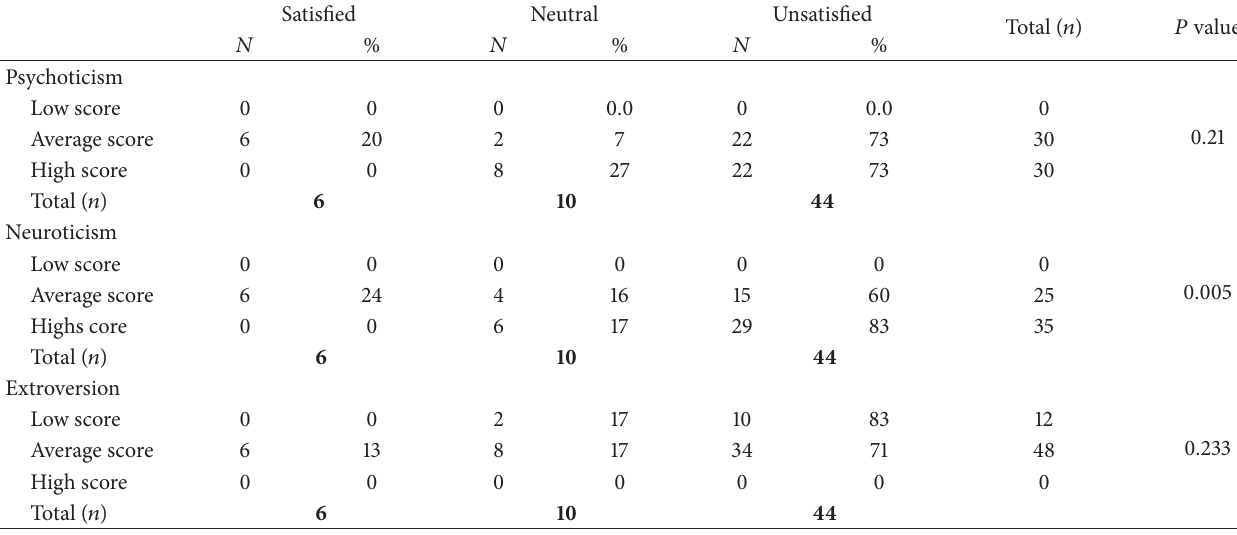
Total ( 𝑛 ) 𝑃 value